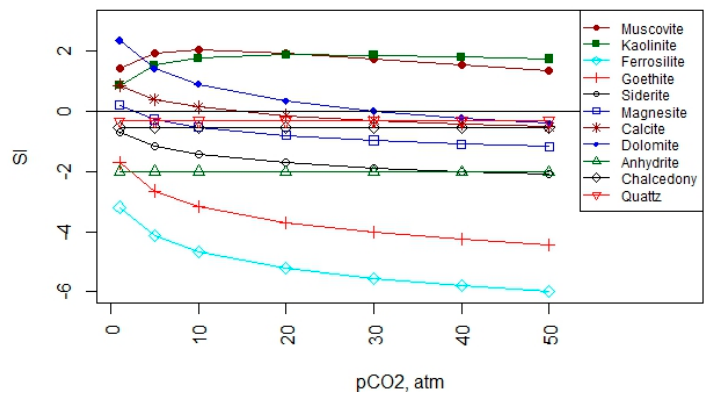
Figure 10. Saturation indices of the selected minerals as a function of partial pressure of CO 2 (Group I higher temperature thermal CO 2 -rich water: Sample 8).